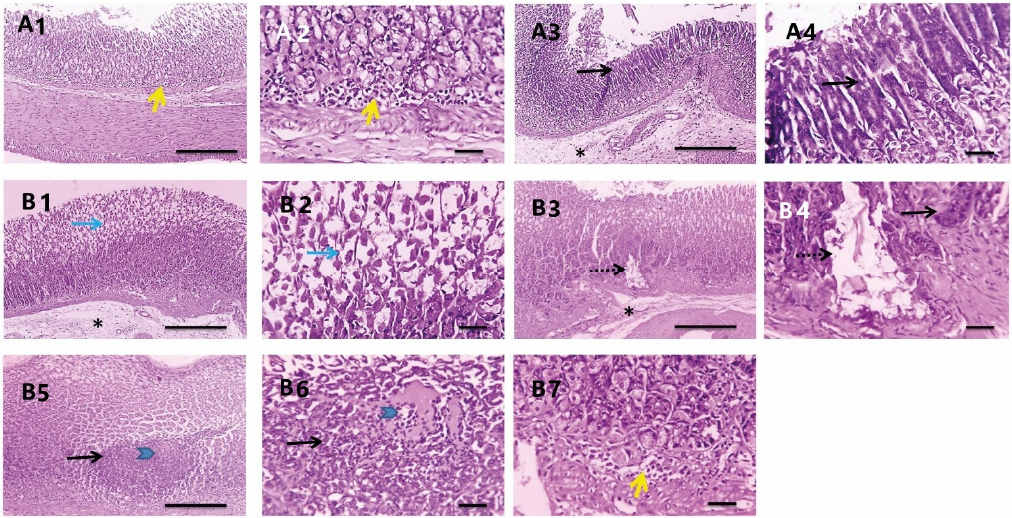
Figure 8. Microscopic pictures of H&E-stained glandular gastric mucosa from H. pylori infected rats treated with PEAME ( A1 – A4 ) showed metaplasia (black arrows) with low mononuclear cell infiltration (yellow arrows) and submucosal edema (*) in some sections. Meanwhile, glandular gastric mucosa from H. pylori infected rats treated with metronidazole ( B1 – B7 ) showed apoptosis (blue arrows), adenoma (dashed black arrows) with metaplasia (black arrows), necrosis (blue arrow- heads), mononuclear cells infiltration (yellow arrows) and submucosal edema (*). Low magnification X: 100 bar 100 and high magnification X: 400 bar